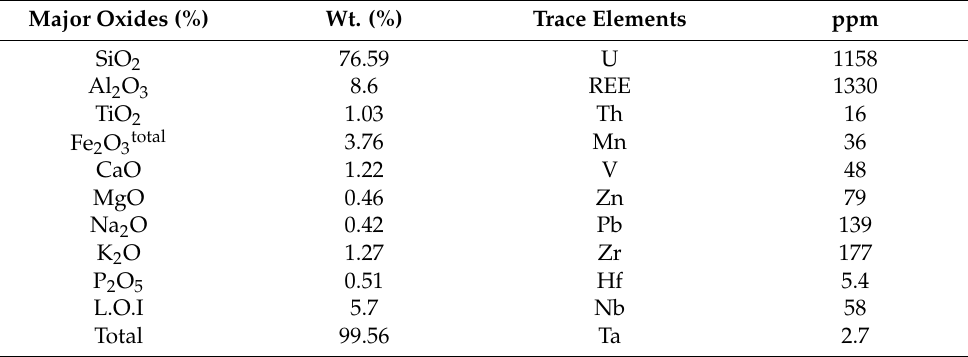
Figure 1. Google image, location map and geological map of El Sela area, South Eastern Desert, Egypt (after Nagar et al., 2016) [58]. Table 1. XRF analysis of the study G. El Sela raw materials.